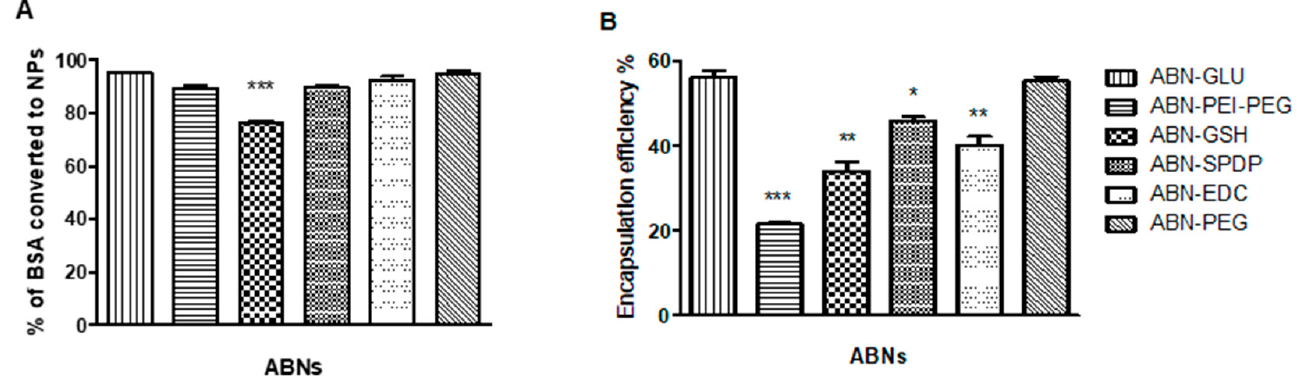
Figure 2. ( A ) Percentage of BSA converted to ABNs measured by Bradford assay and ( B ) Encapsulation efficiency of Dox in ABNs using various cross-linkers. Statistical analysis was performed using one-way ANOVA Tukey’s test. * p -value < 0.01, ** p -value < 0.001, and *** p -value < 0.0001.